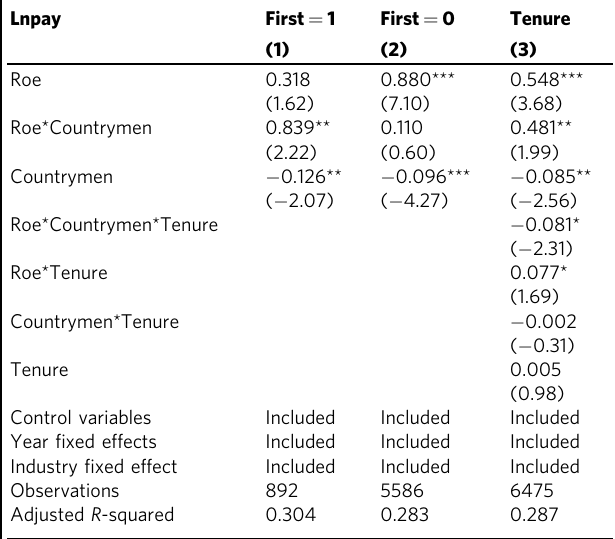
Table 11 In fl uence mechanism based on CEO ’ s